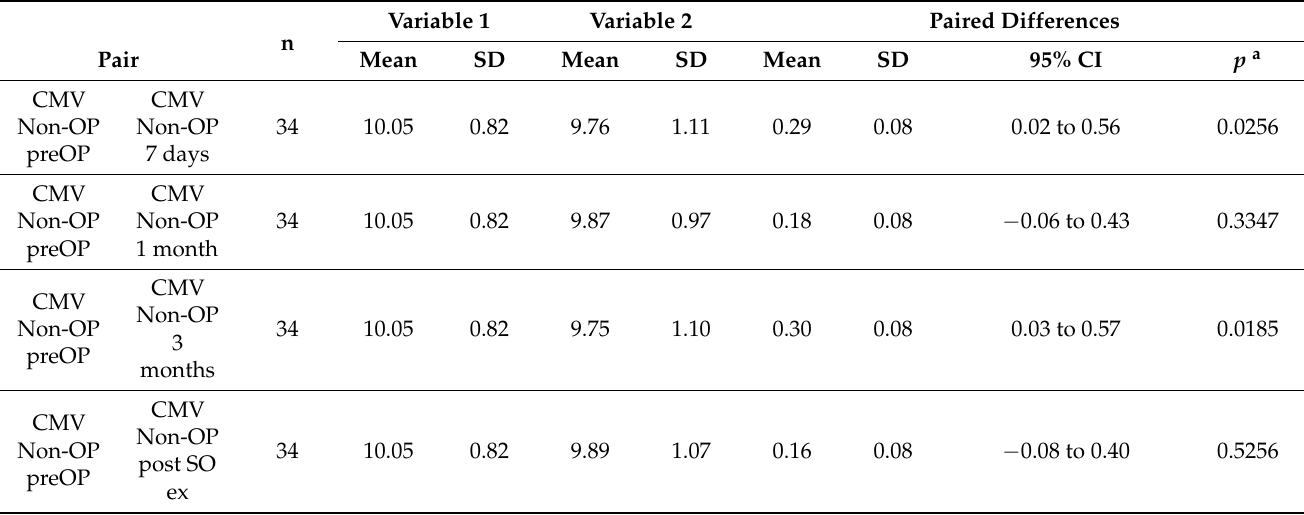
Table 5. Central macular volume cube—CMV (mm3) in non-operated eyes.